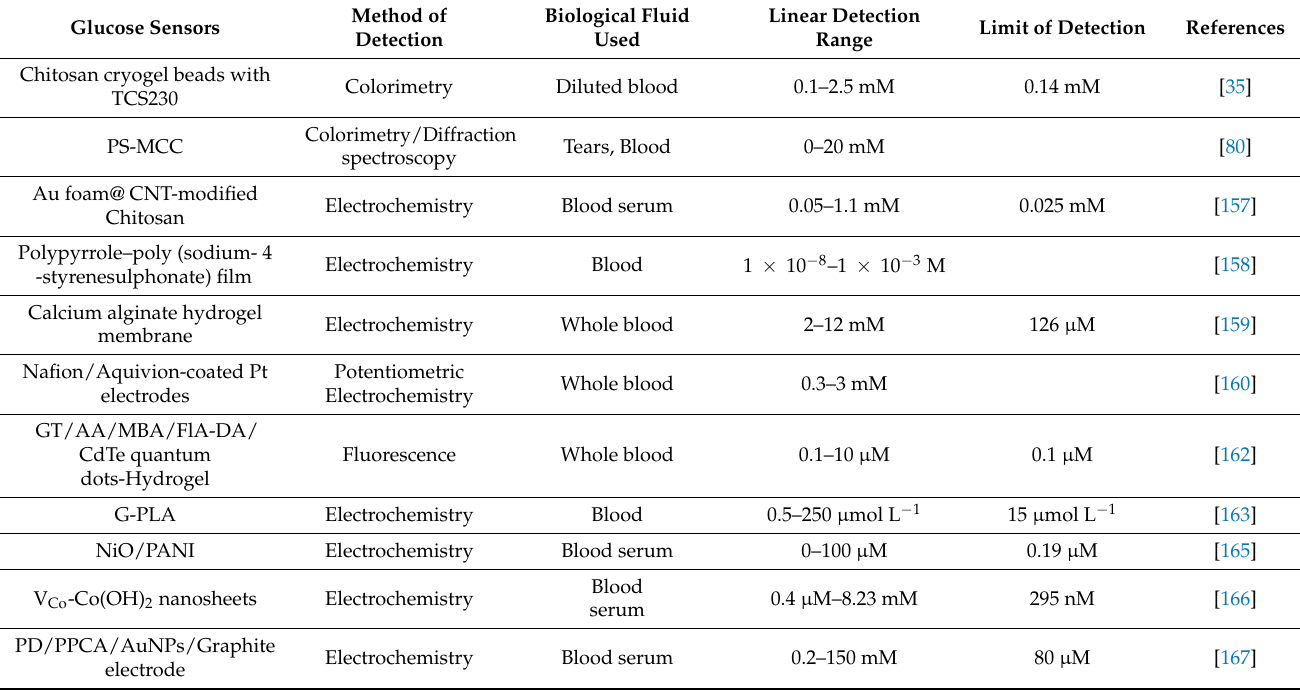
Table 5. The performance of various blood-based glucose